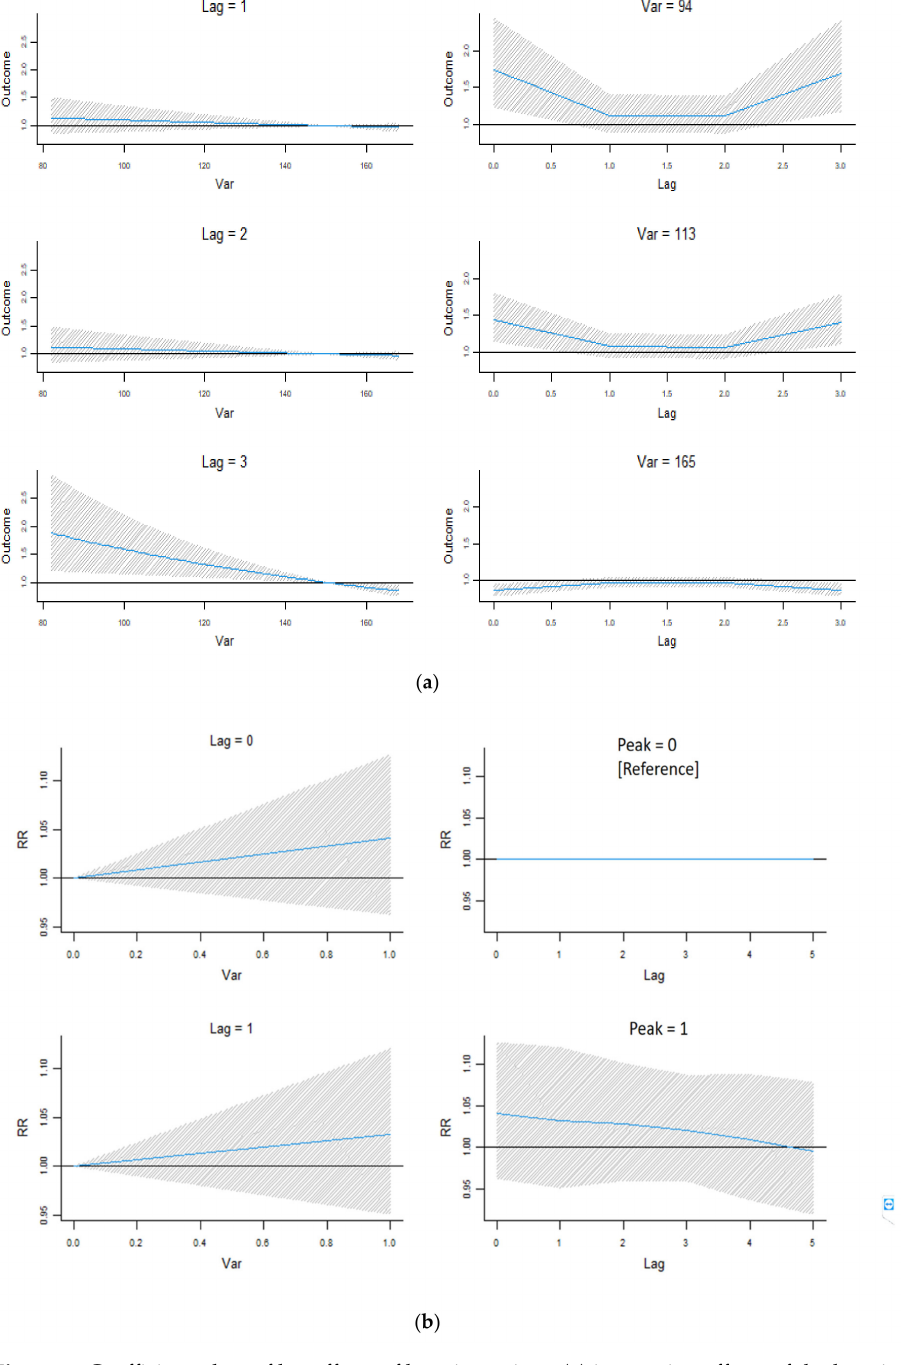
Figure 2. Coefficient plots of lag effects of housing prices: ( a ) interaction effects of the housing index and lag periods and ( b ) interaction effects of the peak in housing prices and lag